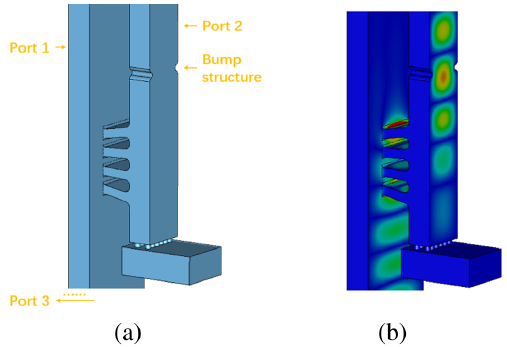
FIG. 3. The principle multibranch directional coupler model, and electrical field distribution in the optimized 0 dB directional coupler. (a) Excited by S-band (b) Excited by